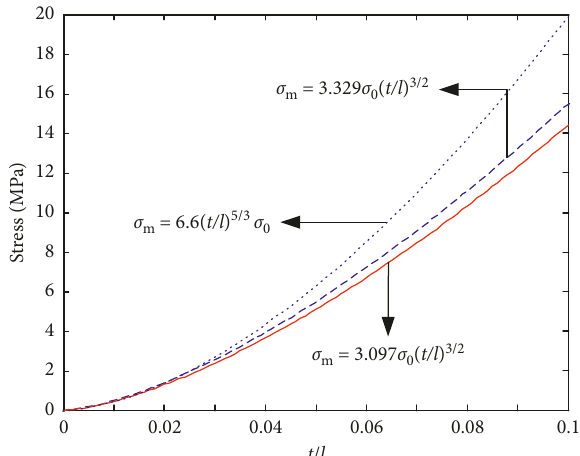
Figure 4: Three calculation models for the mean crushing stress of metal